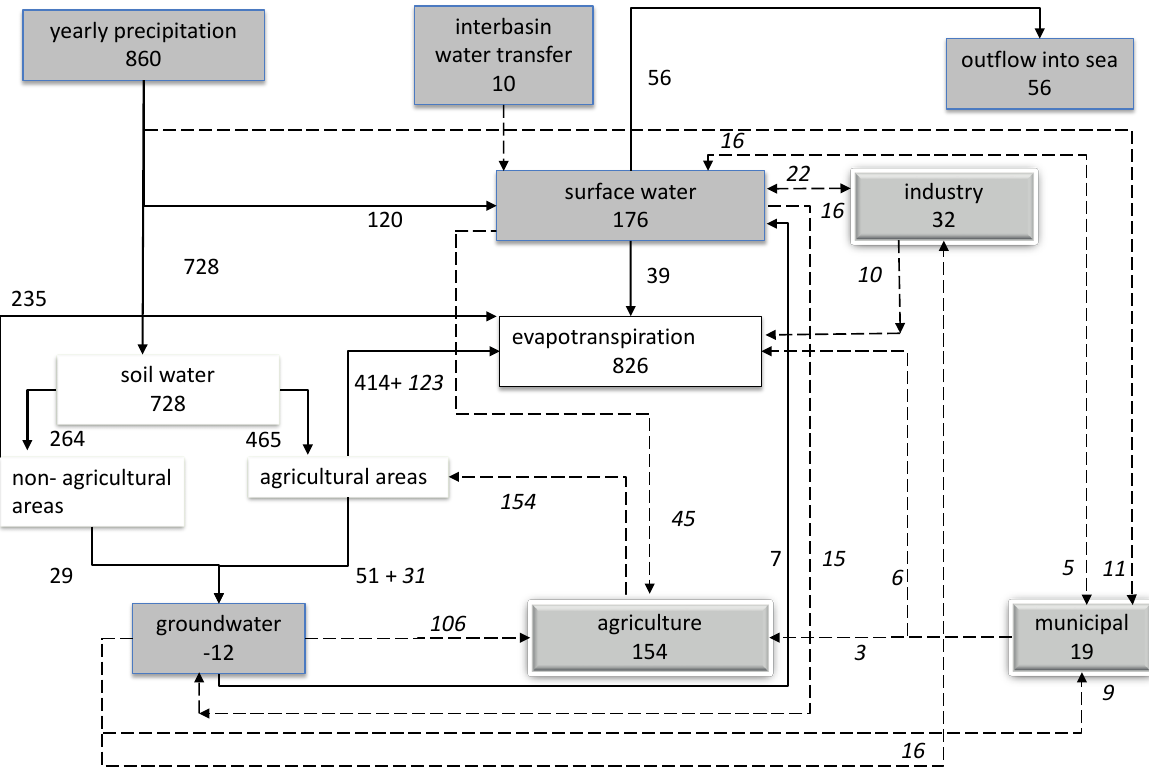
Fig. 2 Dynamic water balance demonstrating the impact of water utilisation (Nijssen 2013). Grey boxes show the available blue water. Dashed lines and italic numbers show human induced water flows, the solid lines the natural flows. All values are given in hm 3 per year.